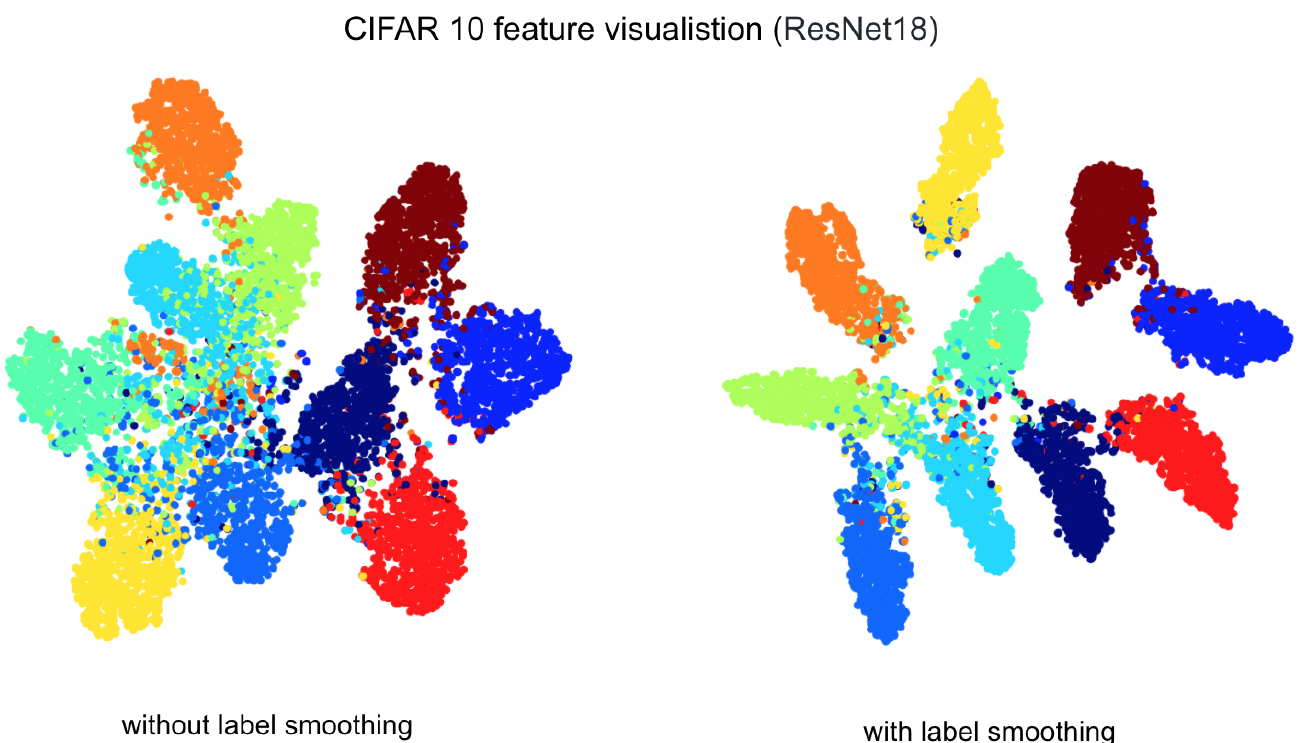
Figure 12. Feature visualisation using TSNE [40] without ( left ) and with label smoothing ( right ) for a classification task. Clearer inter-class boundaries can be observed with the label smoothing